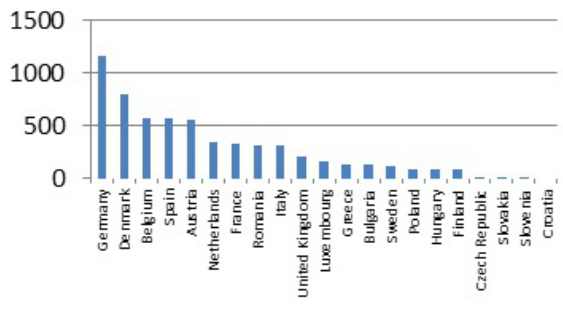
Figure 7. ERTMS contracted tracks [km] in EU